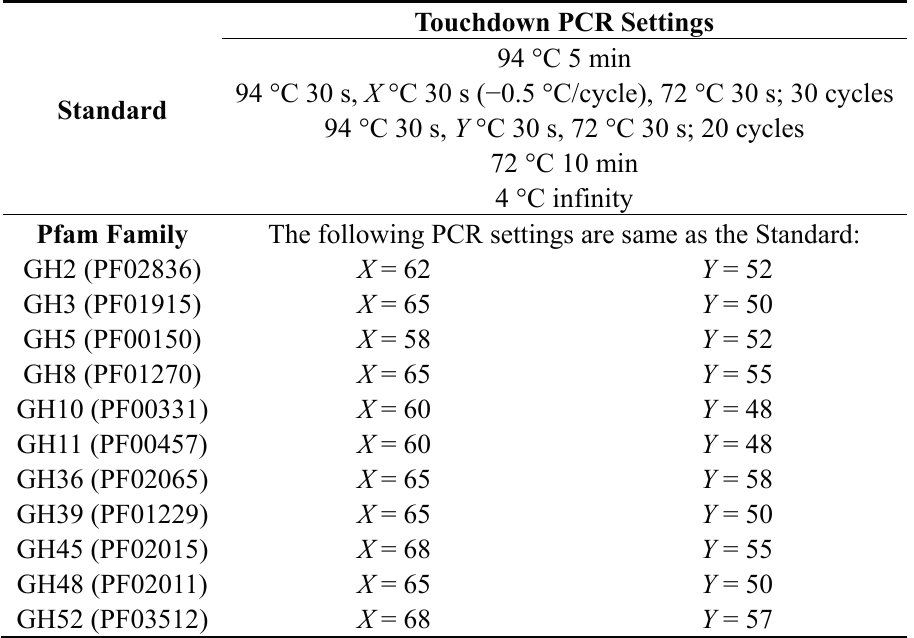
Table 2. Settings for amplification of cellulase and hemicellulase gene